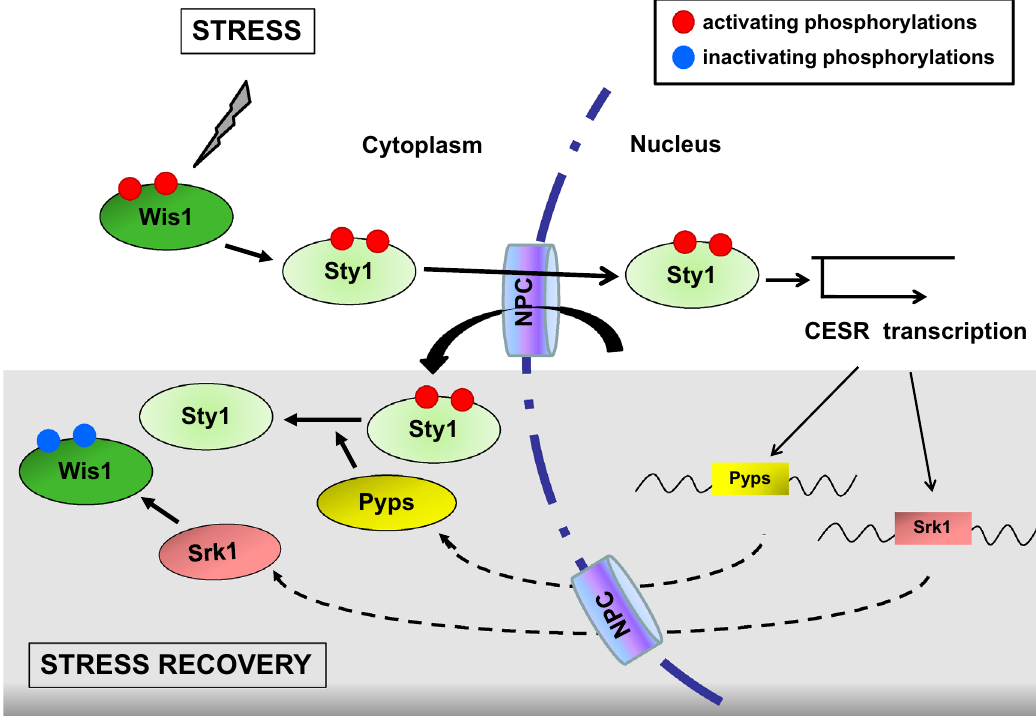
Figure 7. Proposed model for the negative feedback function of Srk1 in the MAPK pathway stress recovery. In response to stress, activation of the Wis1-Sty1 axis induces the transcription of the CESR –Core Environmental Stress Response- genes, including srk1 and pyp1/pyp2 . The presence of the new Srk1 in the cytoplasm phosphorylates Wis1 in the Sty1-binding domain, which disrupts activation of the Wis1-Sty1 axis and allows stress phosphatases, Pyp1 and Pyp2, to inactivate